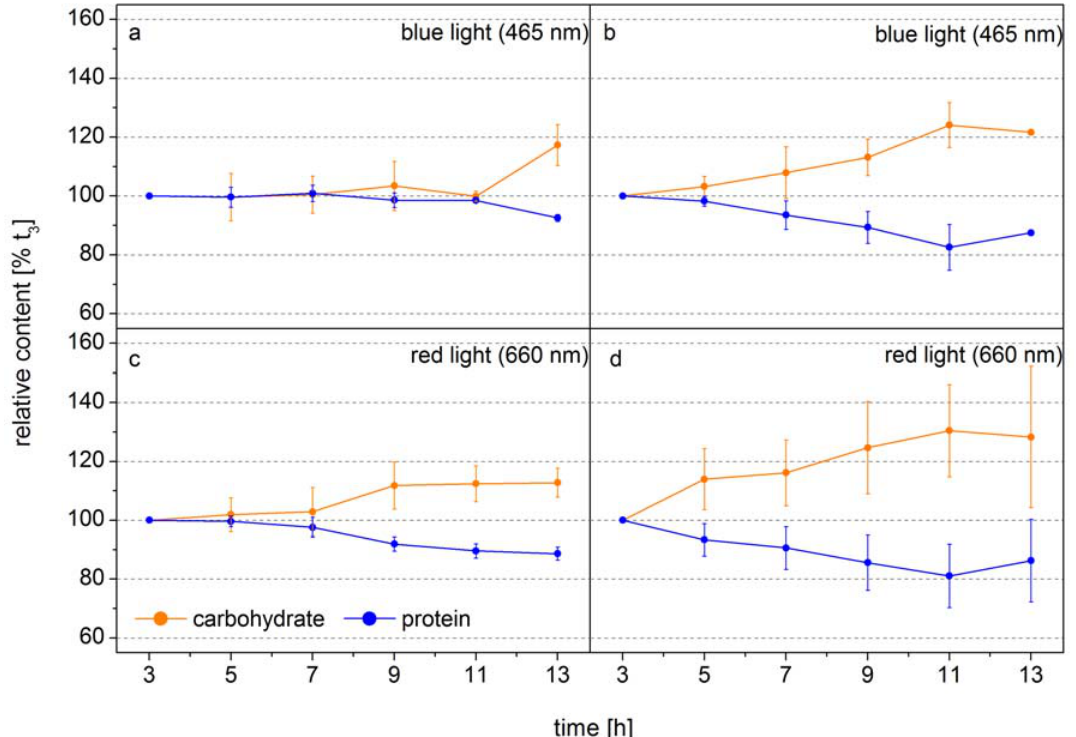
Figure 2. Carbohydrate (orange) and protein (blue) levels of Phaeodactylum tricornutum grown at blue light (465 nm) of ( a ) 10 µmol absorbed photons m − 2 s − 1 (Q absorbed photons m − 2 s − 1 or at red light (660 nm) of ( c ) 10 µmol absorbed photons m − 2 s − 1 and ( d ) 30 µmol absorbed photons m − 2 s − 1 in a 14 h light/10 h dark cycle. The time axes correspond to the time in the light phase. FTIR spectra were detected every 2 h and used for the calculation of the macromolecular composition (according to Wagner et al. 2010). The carbohydrate and protein levels were normalized to the values at 3 h into the light ) (modified according to phase (t 3